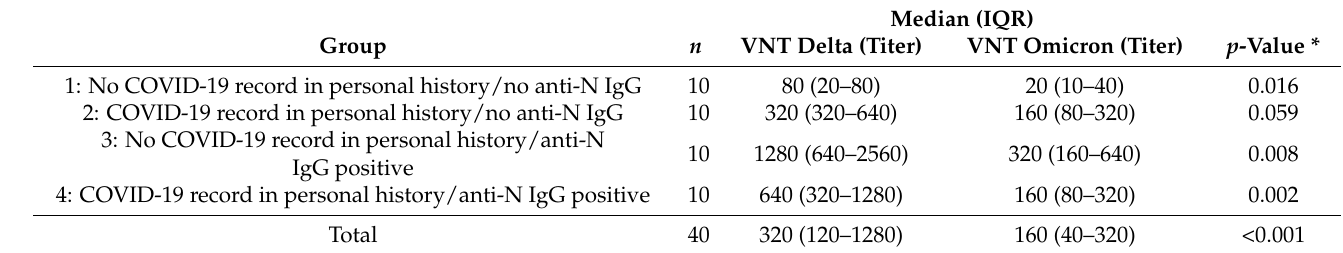
Table 3. Comparison of the virus neutralization titer against delta and omicron